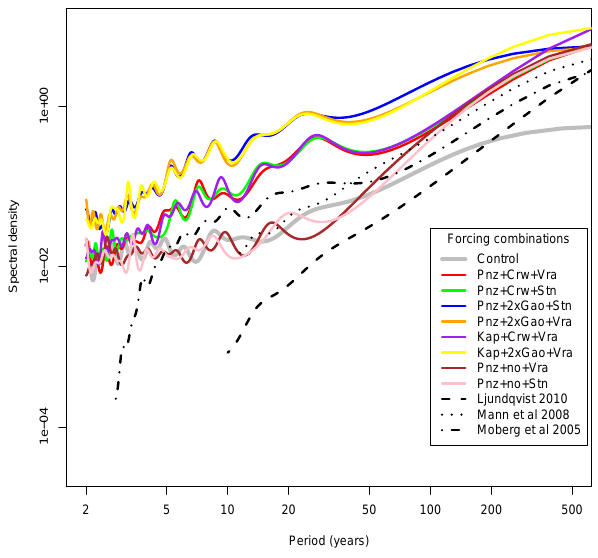
Fig. 11. Spectra from an ensemble of LM simulations using the same model but driven with different sets of forcings compared with Ljundqvist (2010), Mann et al. (2008) and Moberg et al. (2005) re- constructions. The clustering of simulations is driven entirely by changes in the volcanic forcing data set used, with the simulations with the most decadal and multi-decadal variability using the Gao et al. (2008) reconstruction. Only in the examples where no volcanic forcing is used at all is the impact of different solar forcing recon- structions detectable. Spectra derived using MEM with 30 poles, from 850 to 2005, after correction for control run drift using a loess low-frequency estimate derived from the control run. Key abbrevi- ations: Land use: Pnz (Pongratz et al., 2008), Kap (Kaplan et al., 2011); Solar: Vra (Vieira et al., 2011), Stn (Steinhilber et al., 2009); Volcanic: 2xGao (twice the forcing from Gao et al., 2008), Crw (Crowley and Unterman,